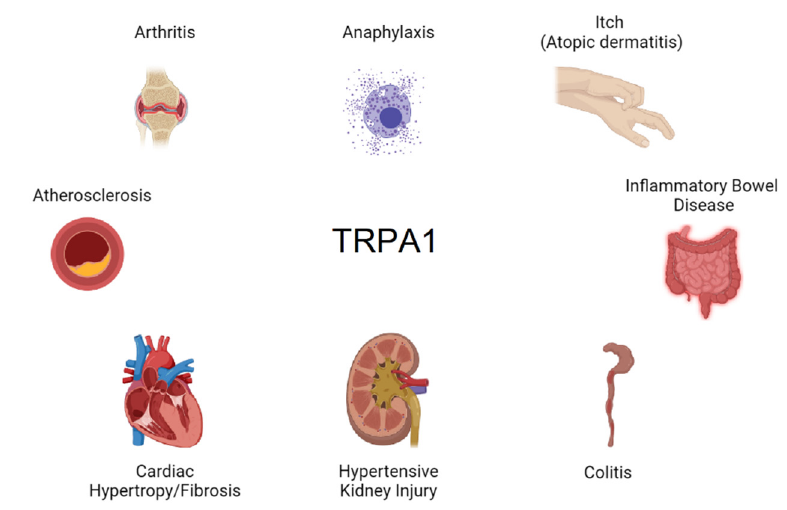
Figure 3. Pathologies linked to the expression of TRPA1 in immune cells .